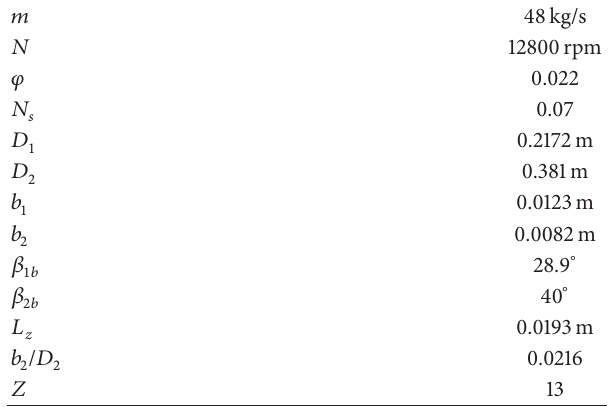
Table 1: Impeller